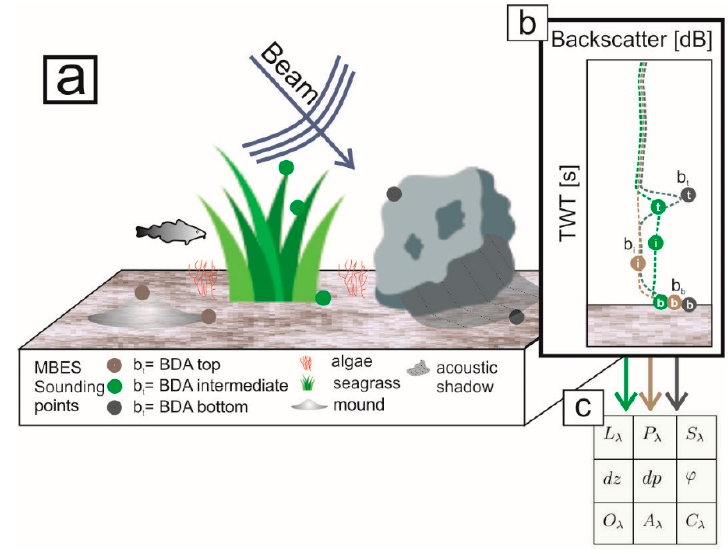
Figure 7. ( a ) Habitat sketch outlining di ff erent “vertical” acoustic features promoting bottom detection algorithms (BDA) misdetections for one beam incident at 45 ◦ . Points show possible distribution of soundings on a plane seafloor and a mound (brown), seafloor covered by seagrass (green), cobbles / boulders (grey). ( b ) schematic backscattering strength signal (Hilbert transformed) shape and BDA picks (points) being modulated by the various substrates shown in ( a ). Indices t , i , and b denote BDA detection domains “top”, “intermediate”, and “bottom”. ( c ) table showing the features created from point clouds, after Equation (3), originating from various beams, pings, and overlapping survey lines.